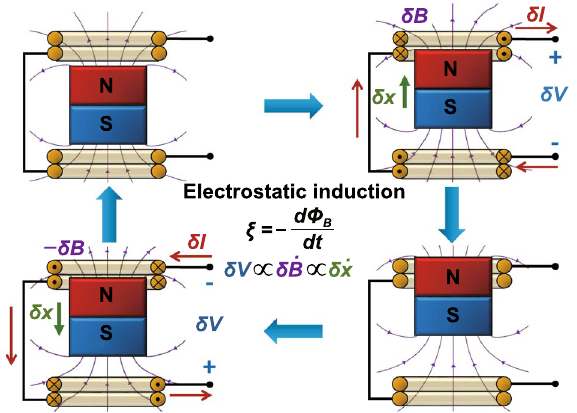
Fig. 6 Schematic representation of the working cycle of a linear magnet/coil EMG based on the phenomenon of electromagnetic induction. Here, δx represents a small displacement of the permanent magnet in relation to the coils, δV and δI a change in voltage and cur- rent in an external circuit, respectively, and δB a change in magnetic induction field. The dots and crosses in the loops of the coils repre- sent currents flowing in the direction out of the plane and into the plane, respectively. (Color figure